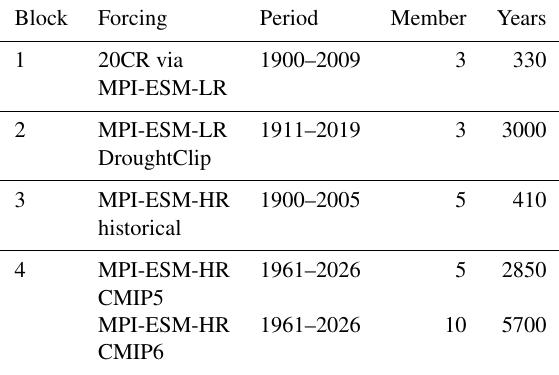
Table 1. Overview of the RCM ensemble LAERTES-EU with the classification into data blocks, the underlying forcing data, the time period covered, and the number of members and simulation years. Table adapted from Ehmele et al.